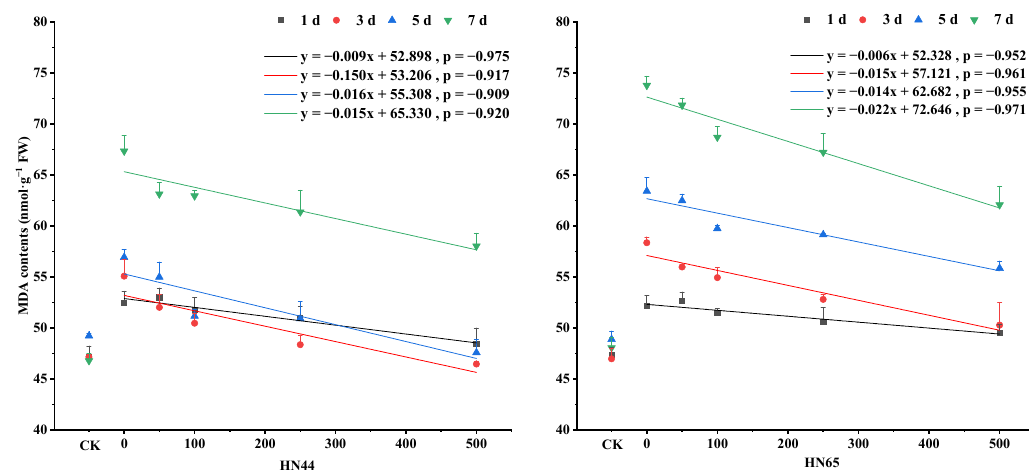
Figure 5. Changes in MDA content during NO alleviation of salt stress. MDA stands for Malondialdehyde. The X -axis, CK represents the control, and the remaining numbers are SNP concentrations sprayed. The values (means ± SE) are the averages of three independent experiments.